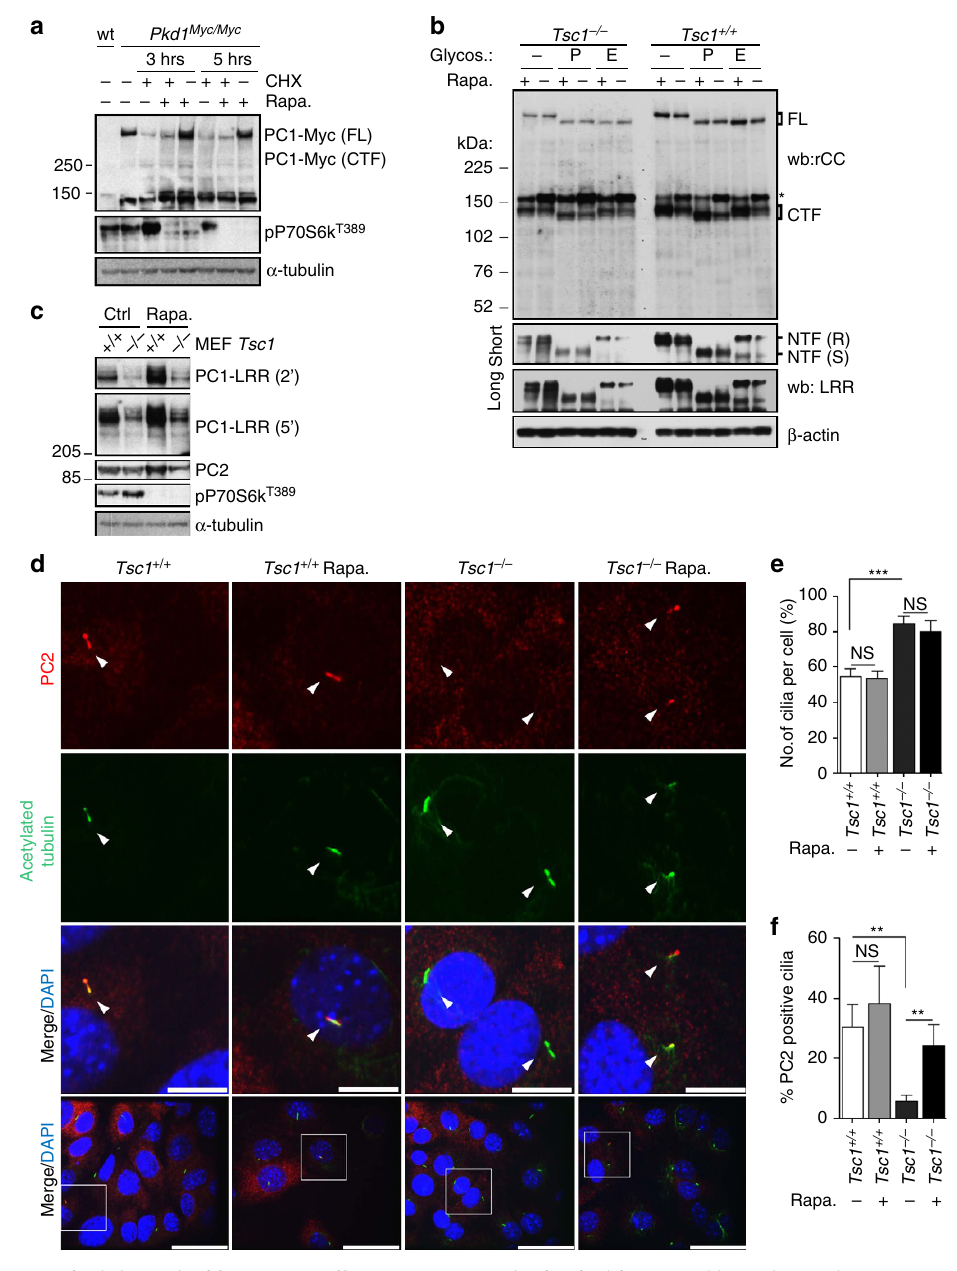
Figure 4 | Protein neosynthesis is required for mTORC1 effect on PC-1 expression levels. ( a ) Western blot analysis with an anti-Myc antibody of Pkd1 Myc/ Myc MEFs in the presence of cycloheximide shows that this prevents the capability of rapamycin (100nM) to upregulate PC-1 levels. ( b ) Immunoblot detecting PC1 (rCC and LRR antibody) in MEFs treated with PNGaseF or EndoH. FL, full-length; NTF, N-terminal fragment; (R), EndoH-resistant; (S), EndoH-sensitive; CTF, C-terminal fragment. ( c ) Western blot detecting PC1 (LRR) and PC2 in Tsc1 þ / þ and Tsc1 (cid:2) / (cid:2) MEFs treated in the presence or absence of 100nM rapamycin. ( d ) Immunofluorescence staining of PC2 (red, arrows) and primary cilia (acetylated tubulin, green, arrows) performed in Tsc1 þ / þ and Tsc1 (cid:2) / (cid:2) MEFs in the presence or absence of 100nM rapamycin for 24h. Scale bar, 10 m m (high magnification) and 40 m m (low magnification). Data are representative of three independent experiments. ( e ) Graph showing the quantification of the percentage of cilia per cell in Tsc1 þ / þ and Tsc1 (cid:2) / (cid:2) MEFs, before and after 100nM rapamycin for 24h. Cells counted: Tsc1 þ / þ n ¼ 281, Tsc1 (cid:2) / (cid:2) n ¼ 437, Tsc1 þ / þ Rapa. n ¼ 166, Tsc1 (cid:2) / (cid:2) Rapa. n ¼ 304. Data are shown as mean ± s.d. and are representative of three independent experiments. ANOVA statistical analysis (*** P o 0.0001) followed by Bonferroni’s multiple comparison (compare selected pairs of columns) test was performed. NS, non significant. ( f ) Graph shows quantification of the percentage of PC2 positive cilia in in Tsc1 þ / þ and Tsc1 (cid:2) / (cid:2) MEFs ( number of cilia shown in e ) before and after rapamycin treatment (100nM for 24h). Data are shown as mean ± s.d. and are representative of three independent experiments. ANOVA statistical analysis (*** P ¼ 0.0007) followed by Bonferroni’s multiple comparison test (compare selected pairs of columns) was performed. NS, non significant; ** P o 0.01. ANOVA, analysis of